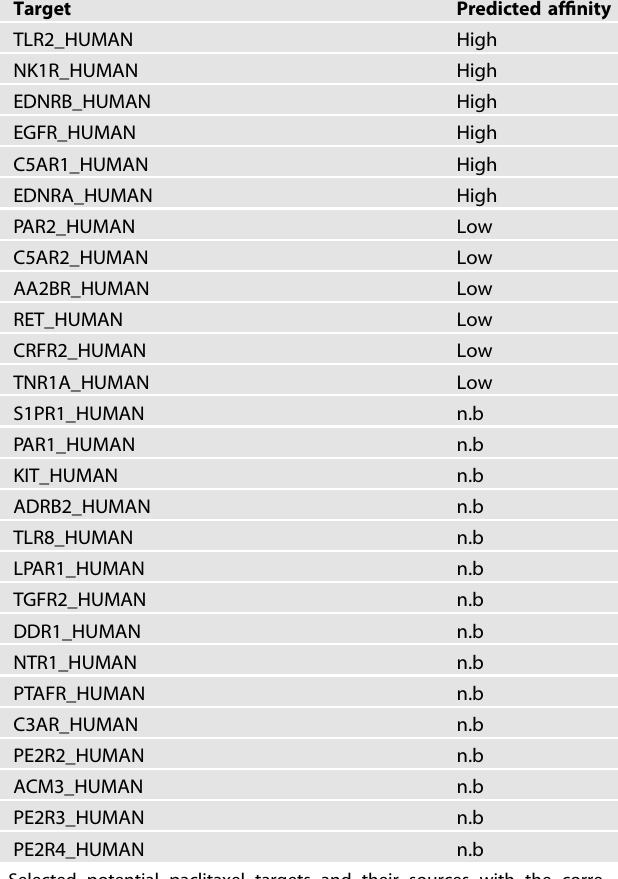
Table 1. Selected potential paclitaxel targets and their predicted af fi